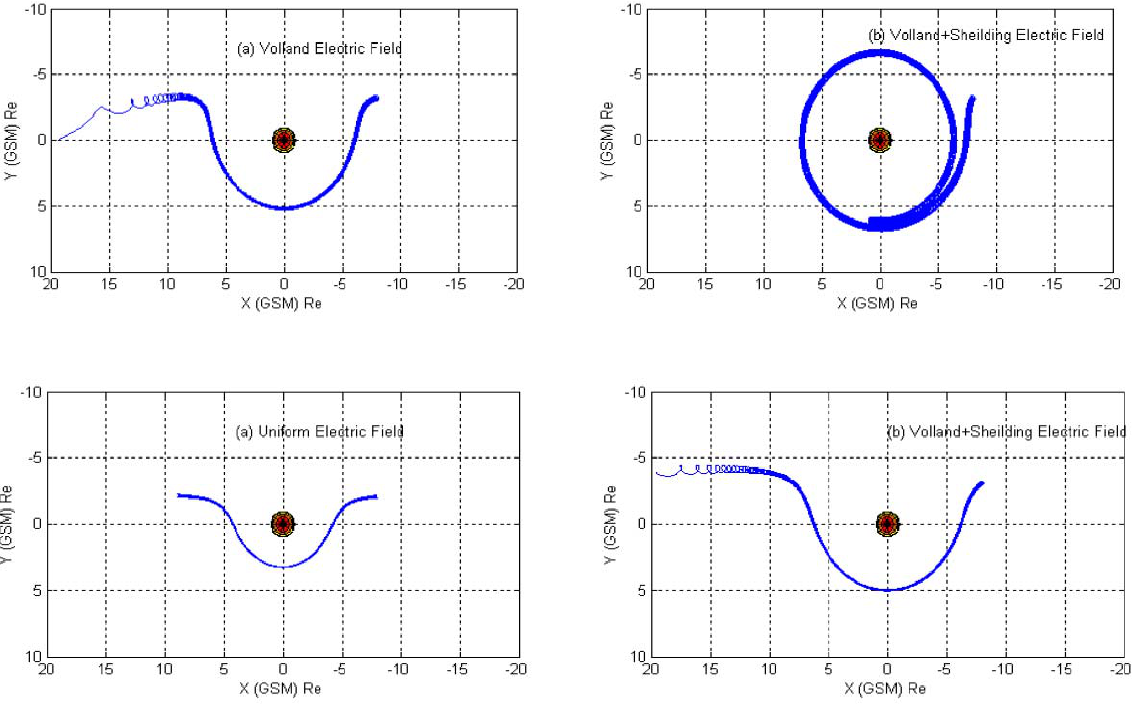
Fig. 9. Different injection paths for an equatorially mirroring O + initially situated at x =− 8 R E , y =− 3 R E and z = 0 with or without the action of the shielding electric field. The initial energy is E = 15keV for the upper panel and E = 5keV for the lower panel.